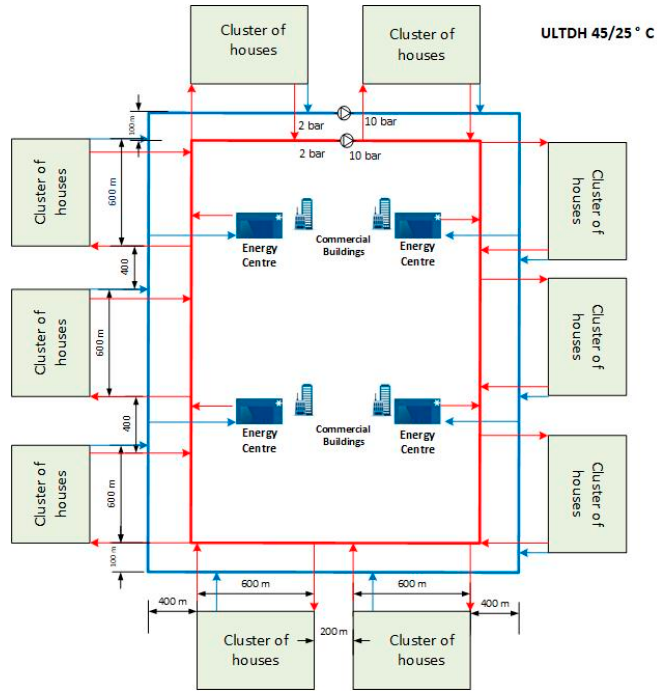
Figure 5. Double-loop configuration for the area.